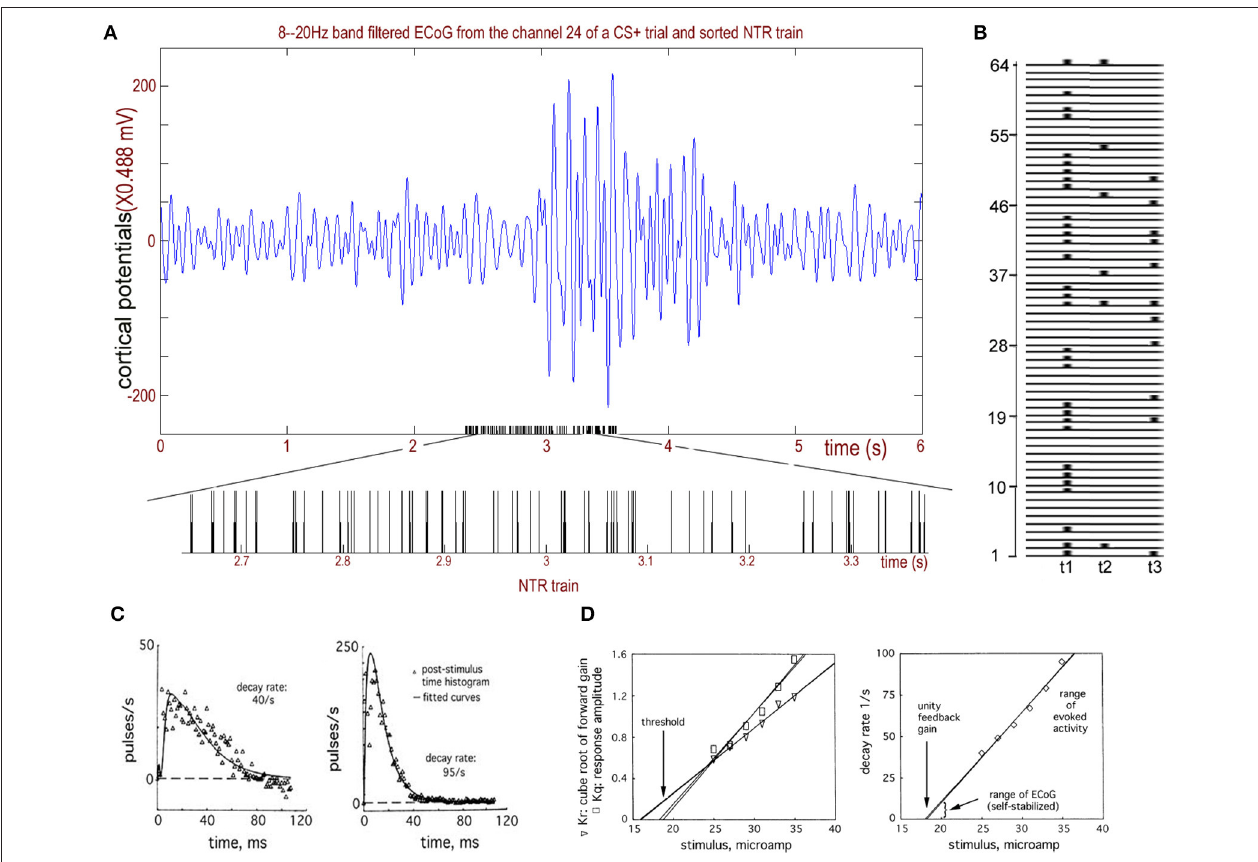
FIGURE 2 | The NTR trains sorted from rabbit ECoGs. (A) Upper: Recorded rabbit ECoGs filtered from the 8 to 20Hz band. Bottom: Sorted NTR trains from the filtered ECoG data. (B) Calculating example for T(k) from sorted NTR trains of 64 channels. (C) Two examples of the impulse responses of the bulbar periglomerular mutually excitatory population at lowest and highest stimulus intensities give decay rates of 40/s and 90/s, respectively, and rising rates of 500 and 300/s, respectively. (D) Left: The relation for the stimulus intensity gives the threshold of the impulse response to an excitatory stimulus; Right: The relation of decay rate to stimulus. Adapted from Freeman and Zhai